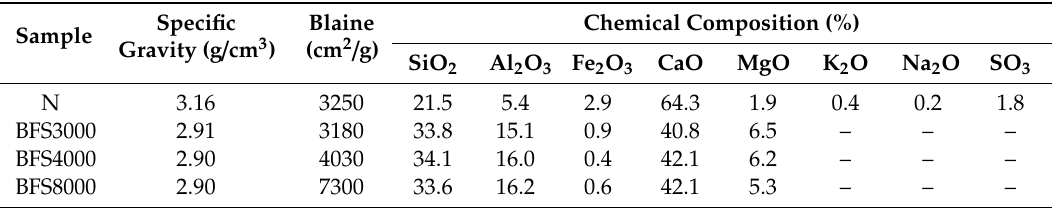
Table 1. Chemical composition and physical properties of ordinary Portland cement and blast furnace slag